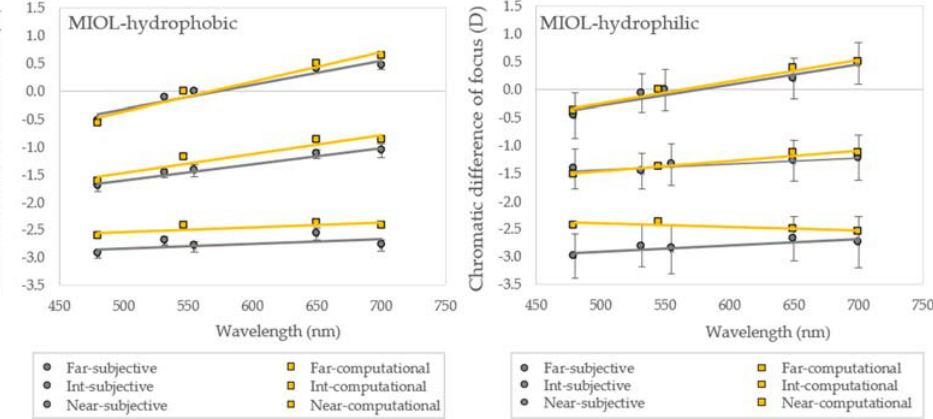
Figure 6. Average chromatic difference of focus (CDF) for multifocal vision. CDF for hydrophobic and hydrophilic MIOLs for far (0 D), intermediate (1.75 D), and near (3.50 D) vision measured with subjective (gray circles) and computational (yellow squares) techniques. Error bars stand for inter-subject variability in all cases.